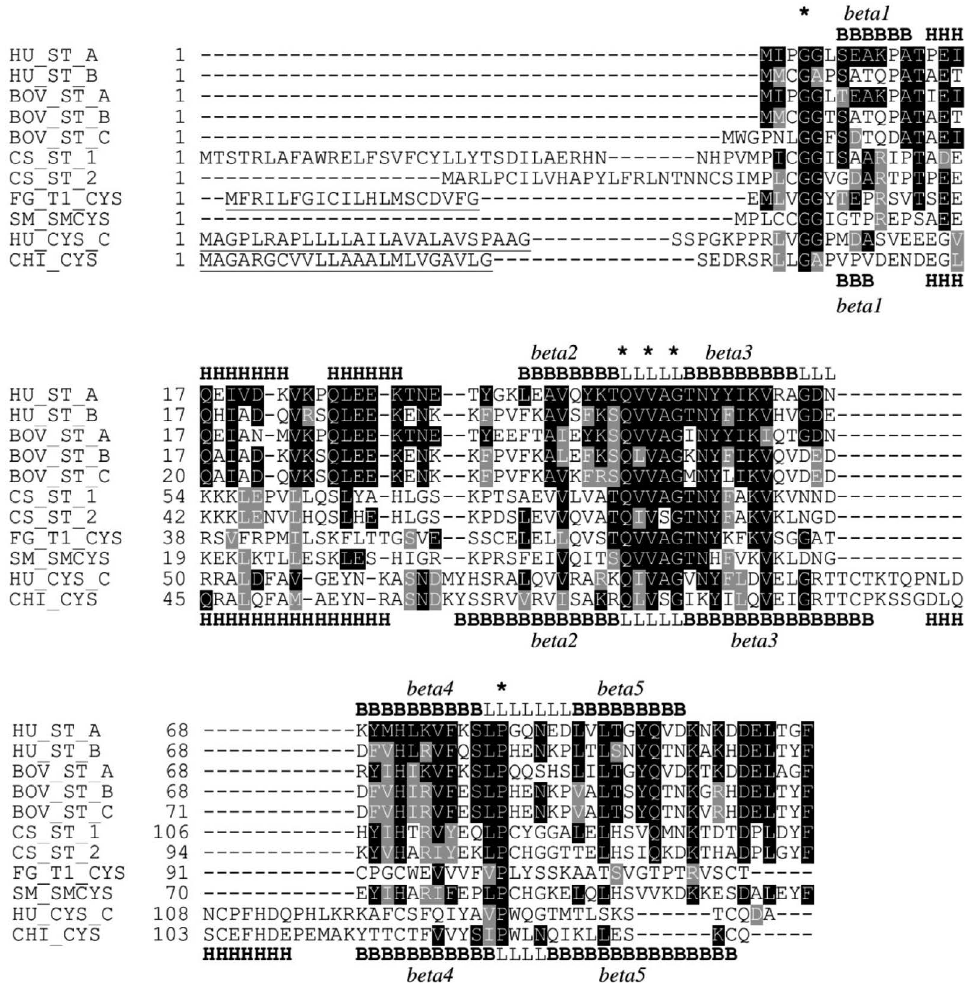
Figure 1. Multiple sequence alignment of stefins and cystatins. The alignment was performed by Clustal Omega using sequences obtained from Uni- Prot. 128 Conserved residues in comparison to human stefin A (HU_ST_A, P01040) are marked using BoxShade as black background, and similar resi- dues have gray background. Asterisks represents conserved residues forming tripartite wedge-shaped edge interacting with the active site of an enzyme. Signal sequences are underlined. Secondary structure elements alpha-helices (H) and beta-sheets (B), and loops (L) are indicated for stefin A (above) and for chicken cystatin (below). Five-stranded antiparallel beta - sheets are numbered. Other aligned inhibitors are: human stefin B (HU_ST_B, P04080), bovine stefins A (BOV_ST_A, P80416), B (BOV_ST_B, P25417), and C (BOV_ST_C, P35478), stefins 1 (CS_ST_1, A6YID9) and 2 (CS_ ST_2, A6YE0) from Clonorchis sinensis , Type-1 cystatin cysteine protease inhibitor from Fasciola gigantica (FG_T1_CYS, K4P3W9), cystatin B (stefin type) from Schistosoma mansoni (SM_SMCYS, Q7YW72), human cystatin C (HU_CYS_C, P01034), and chicken cystatin (CHI_CYS,